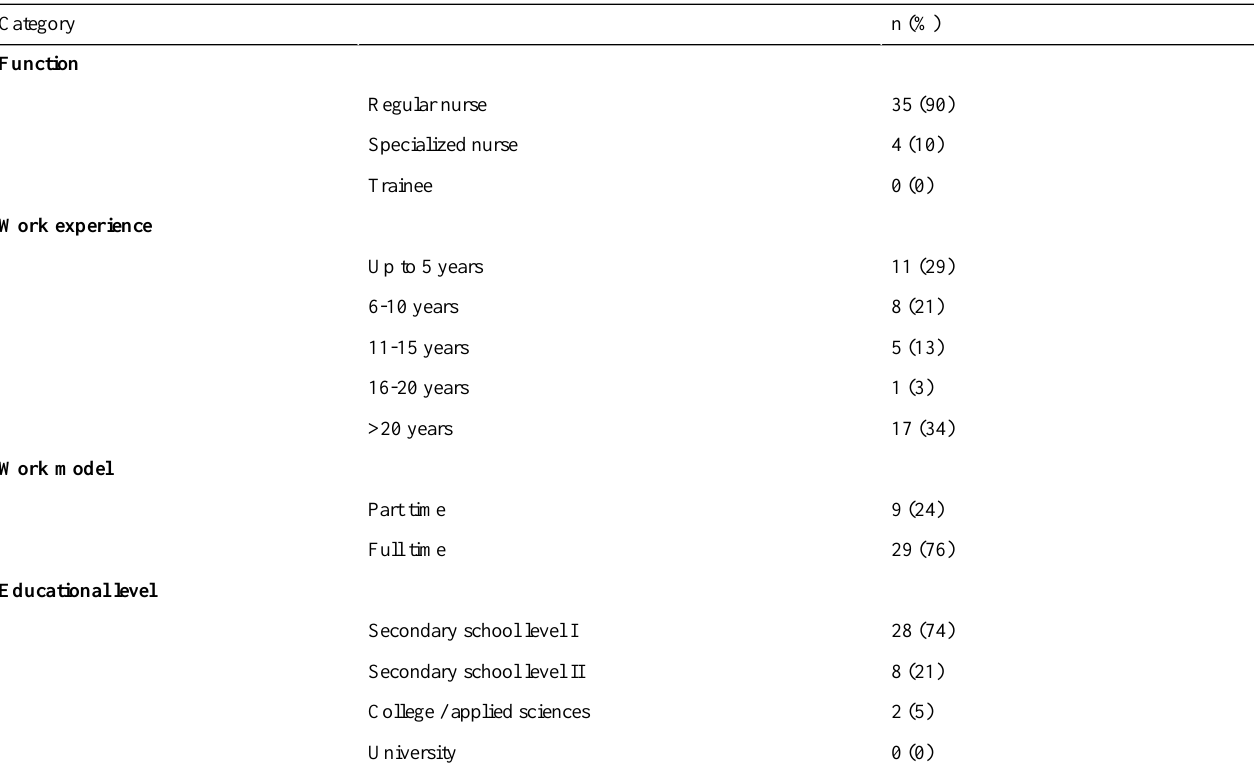
Table 3. Job functions (N=39), work experience (N=38), work model (N=38), and educational level of the participants.